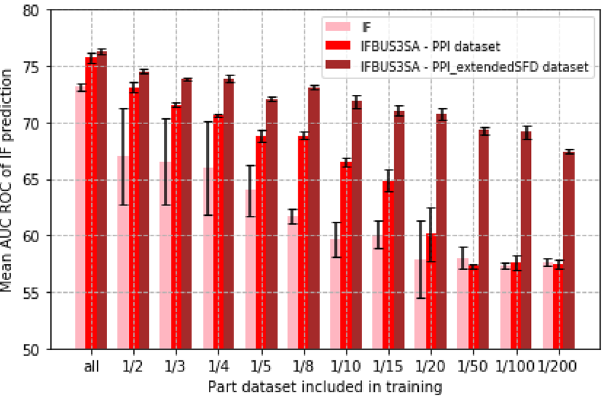
Figure 4. The importance of the multi-task setup and the data extension when training a PPI interface prediction model trained on limited data. The single-task model IF (pink) and the multi-task model IFBUS3SA (red and brown) are compared. The IF model and the IFBUS3SA model indicated in red are trained on a part of the PPI dataset. Differences in performance between the pink and red bars therefore presents the benefit of the multi-task learning strategy. The IFBUS3SA model in brown is trained on the PPI_extendedSFD dataset in which only a part of the PPI interface information is considered. All the brown bars are thus trained on the same number of sequences for which the related task information is available. Differences in performance between red and brown bars indicate the benefit of training the model on the augmented PPI_extendedSFD dataset. Model performance is shown by the mean AUC ROC (bars) and standard deviation (whiskers) of the PPI interface prediction on the total validation